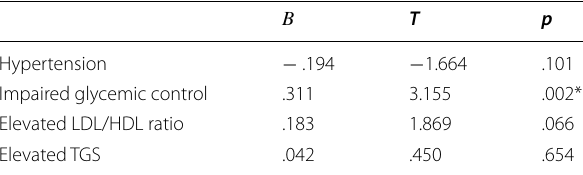
Table 7 Linear regression for prediction of Log anxious